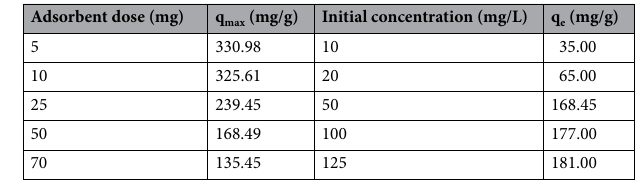
Table 5. The summary of adsorption capacity at variation of silica NSG adsorbent dosage and initial concentration of MB.